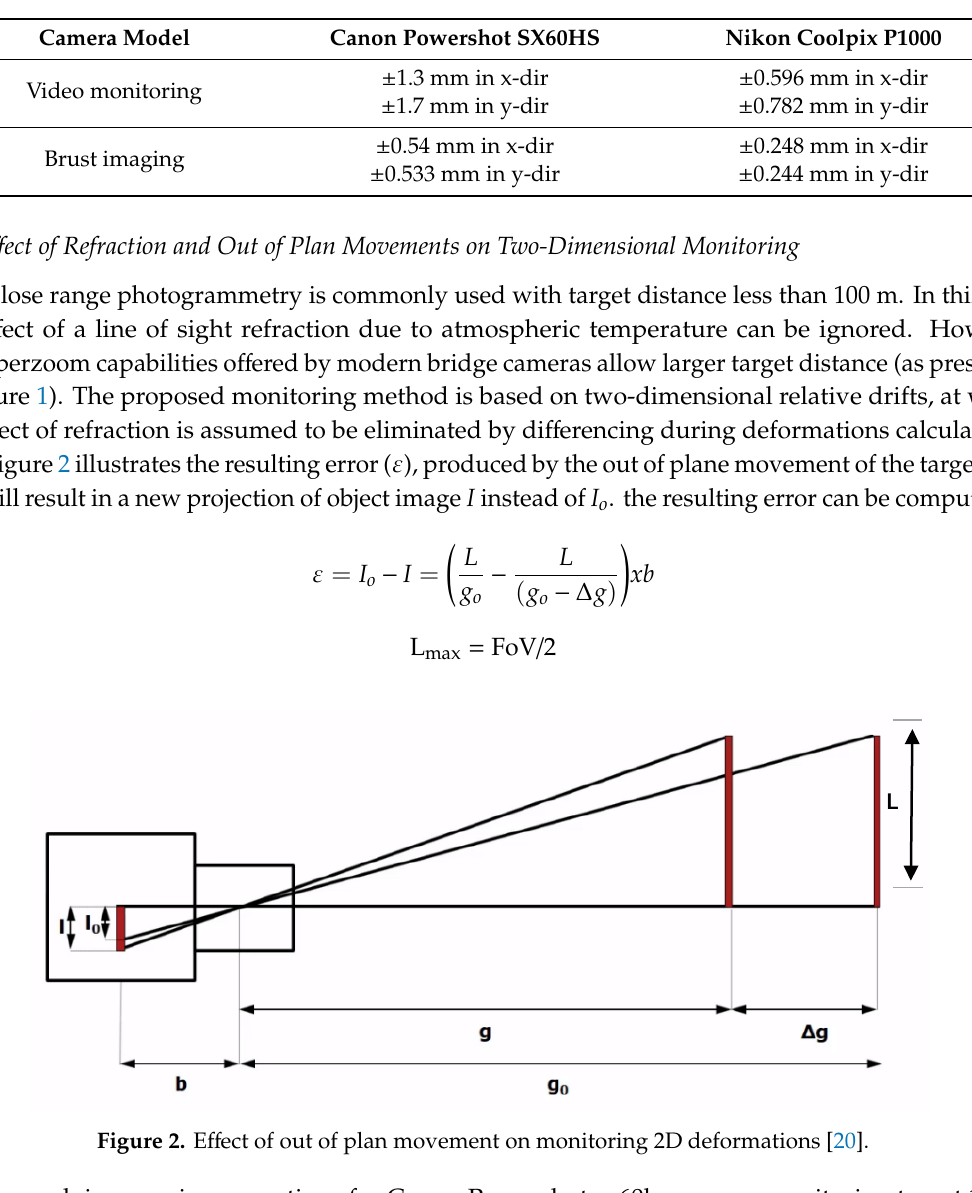
Table 2. Summary of analyzed camera sensors precision for monitoring target 100 m apart.